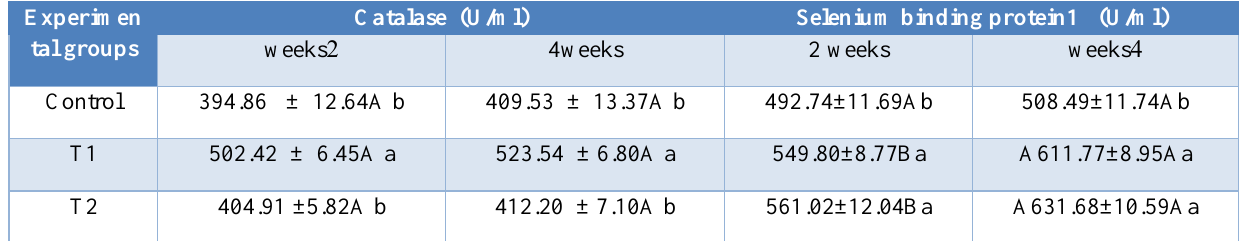
Table, 3 serum catalase activity (U/ml) and Serum Selenium binding protein (U/ml) activity under effect of biogenic Se- Nanoparticles in compare with selenite solution during 2 , 4 weeks, Means ±SE. n-